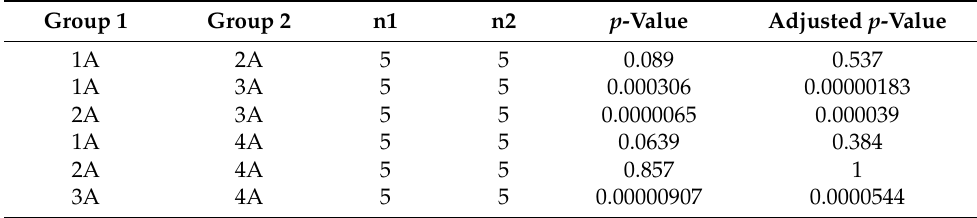
Table 5. Results of Student’s t -test with Bonferroni adjustment.